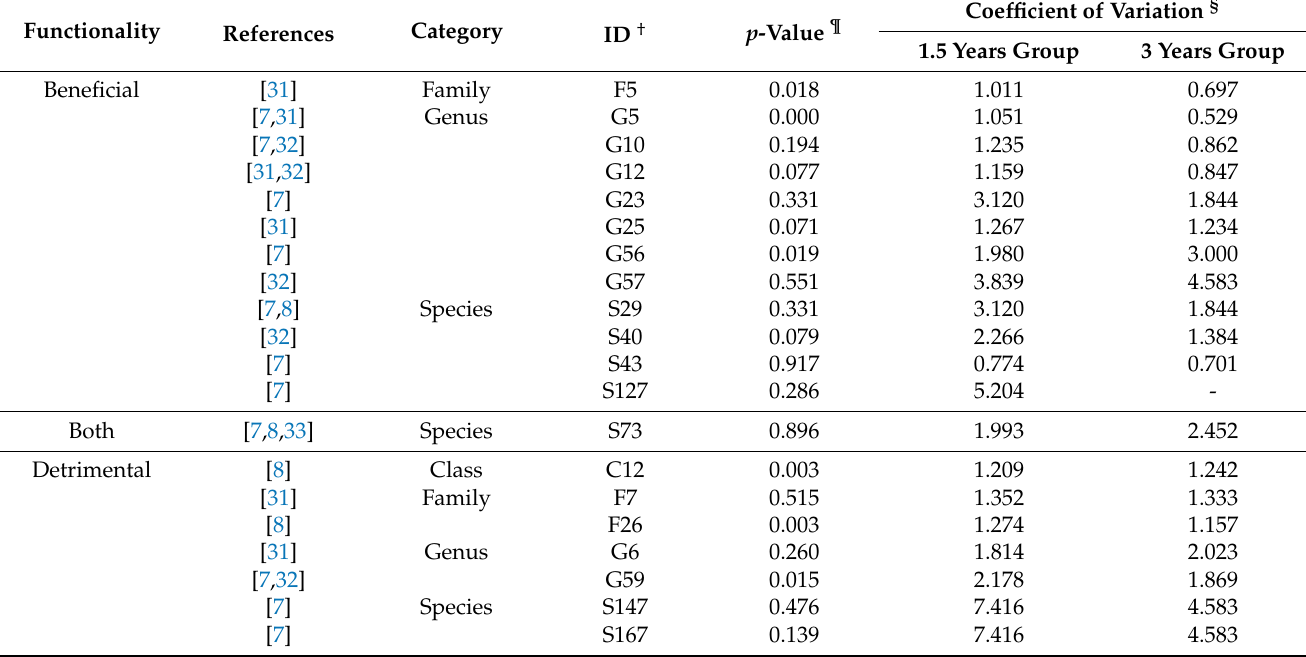
Table 5. Between-age comparisons of potentially beneficial or detrimental bacteria detected in Research